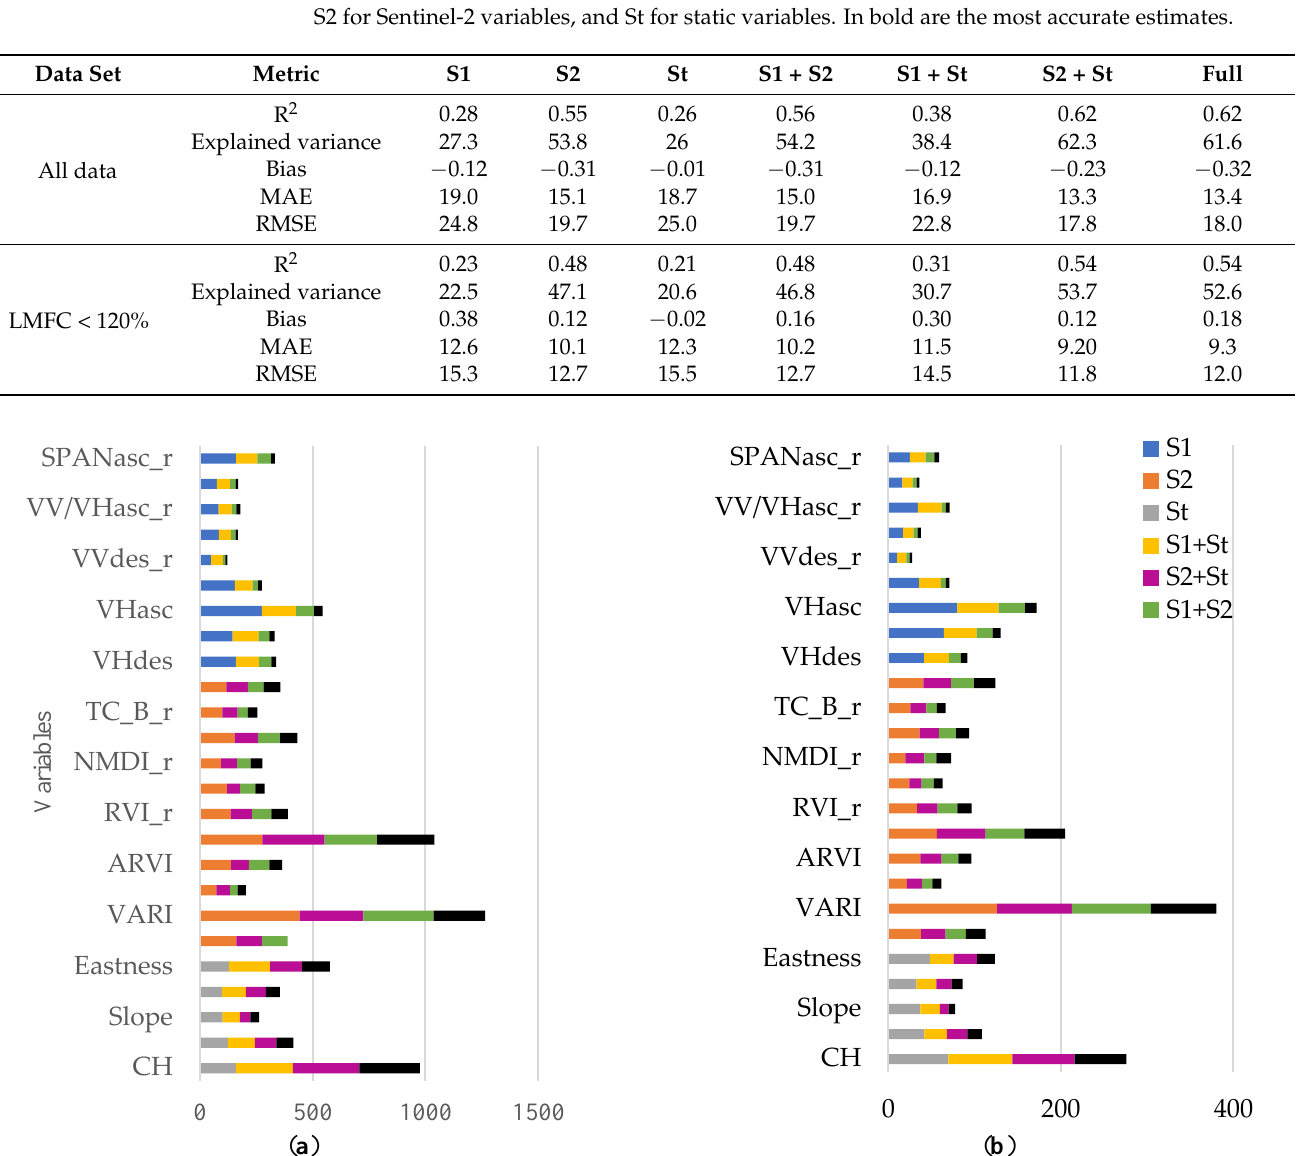
Figure 4. Predictor variables ’ importance (horizontal axis) by model when all data are used for modeling ( a ) and when low (<120%) LFMC values (high fire risk scenario) are modeled ( b ).